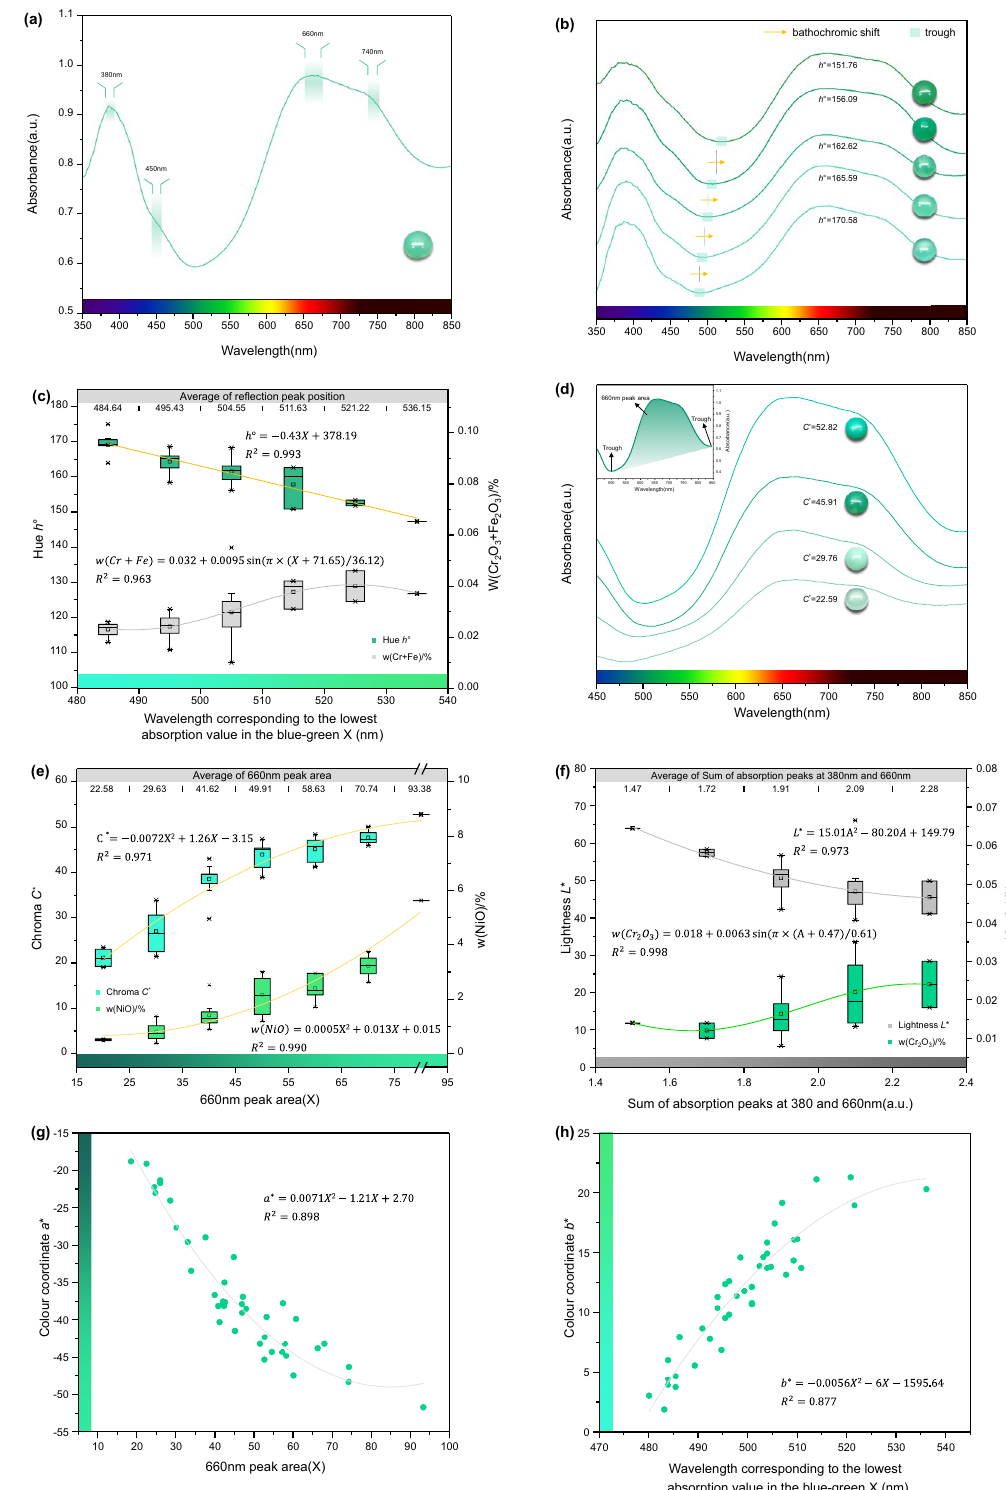
Figure 4. UV–Vis spectra for chrysoprase samples. ( a ) The UV–Vis spectra of chrysoprase are characterized by Ni 2+ absorption features. ( b ) The transmission window between the two main bands of chrysoprase centred at 380 and 660 nm is responsible for the hue of the samples. ( c ) Relationship between the wavelength corresponding to the lowest absorption value in the blue–green region and hue and w(Cr 2 O 3 + Fe 2 O 3 ). ( d ) The larger the area of the 660-nm absorption peak, the greater the chroma of chrysoprase. ( e ) Relationship between the 660-nm peak area and chroma and w(NiO)%. The chroma and Ni content of chrysoprase increase with increase of the 660-nm peak area. ( f ) Relationship between the sum of absorption peaks at 380, 660 nm and lightness and w(Cr 2 O 3 ). ( g ) The larger the area of the 660-nm absorption peak, the smaller the colourimetric coordinates a * value. ( h ) With the increase of the wavelength corresponding to the lowest absorption value in the blue–green region of the spectrum, the colourimetric coordinates b * value